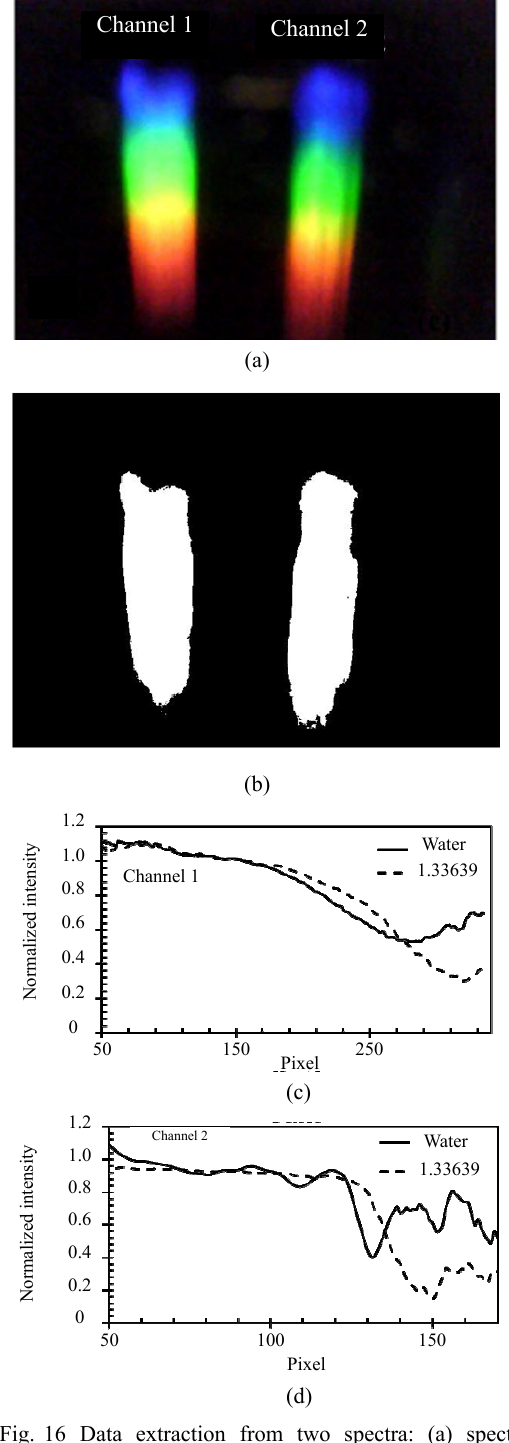
Fig. 16 Data extraction from two spectra: (a) spectrum captured by multi-channel spectrometer, (b) the binary image of the frame where the spectrum is highlighted by white pixels, indicating the region of interest, (c) intensity response of Channel 1 for water, and solution of RI 1.33639, and (d) intensity response of Channel 2 for water and solution of RI